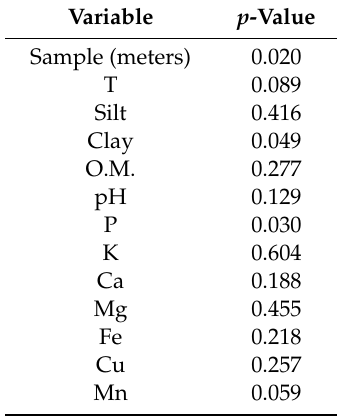
Table 2. Analysis of generalized linear models (GLM) between the cultivable fungus community and the environmental variables of the Collins Glacier (Fildes Peninsula, South Shetlands Archipelago, King George Island, Maritime